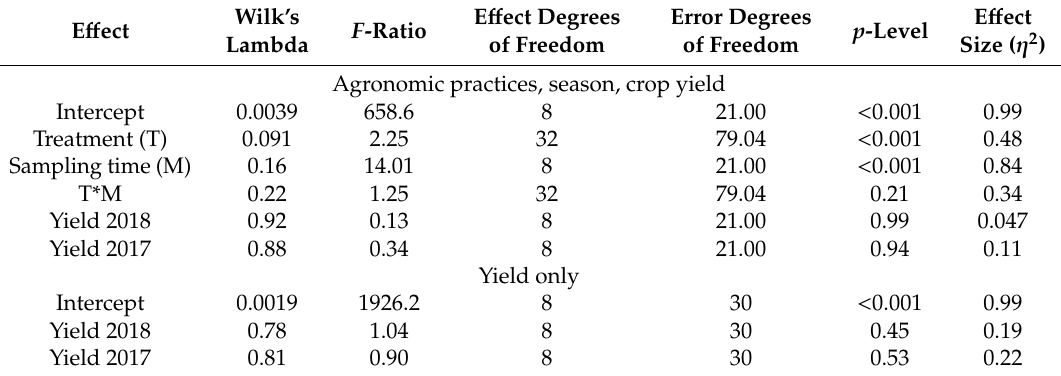
Table 5. Multivariate GLM results examining the e ff ect of treatment type, season, and crop yield as continous predictor on nematode assemblage synecological parameters.